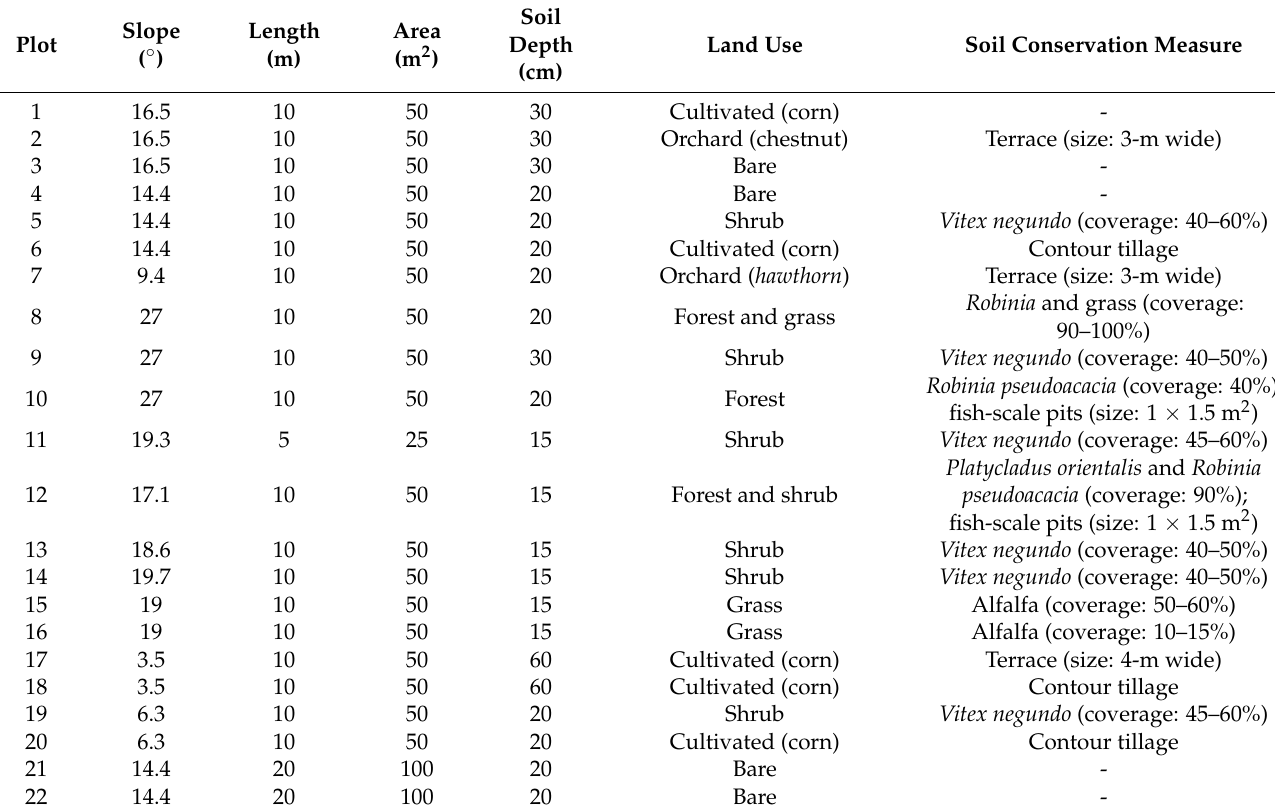
Table 1. Characteristics of the 22 plots. Note: all of the treatments were applied for all seven years (i.e., 2014–2020); the vegetation coverage in the plots was obtained through visual estimation.